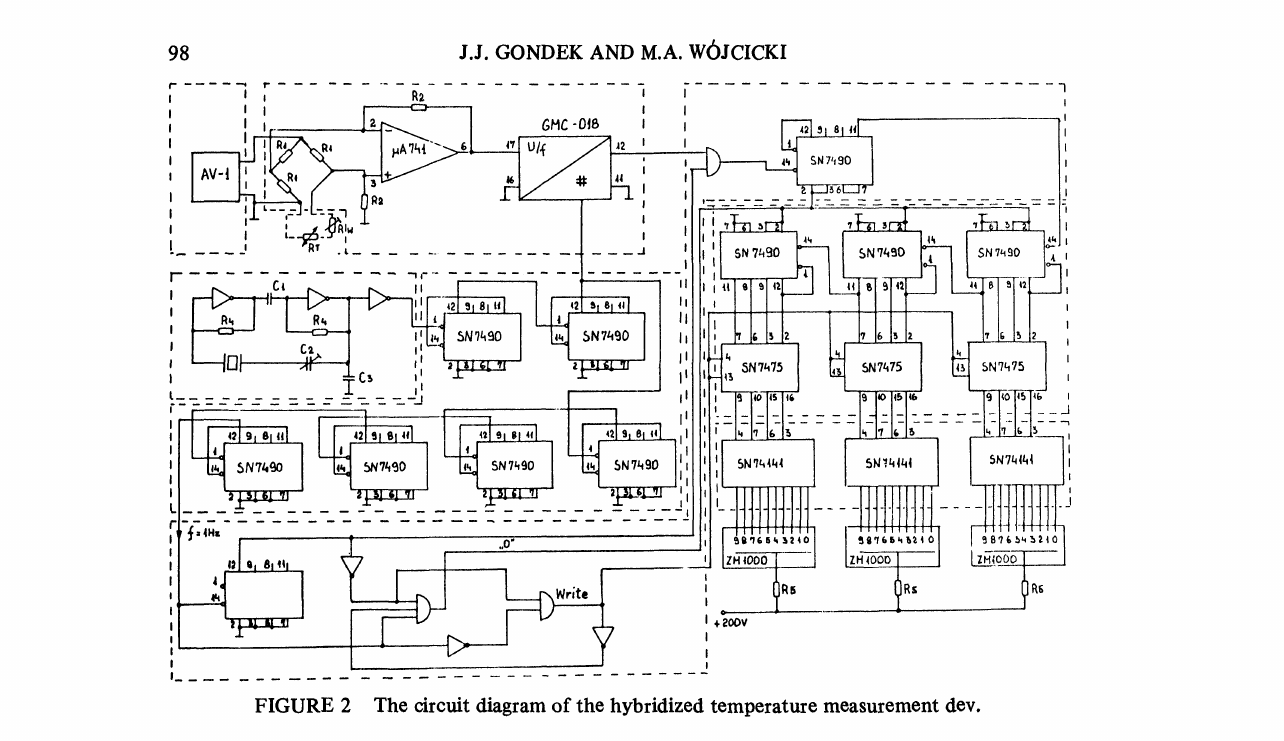
FIGURE 2 The circuit diagram of the hybridized temperature measurement